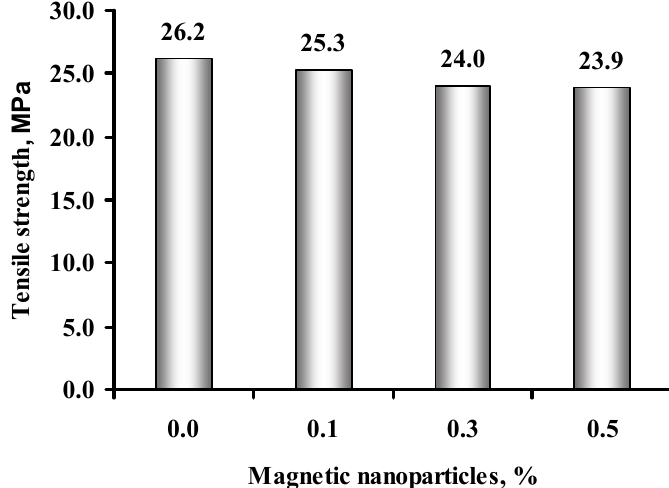
Figure 5: Tensile strength of magnetic composites with different content of magnetic nanoparticles.